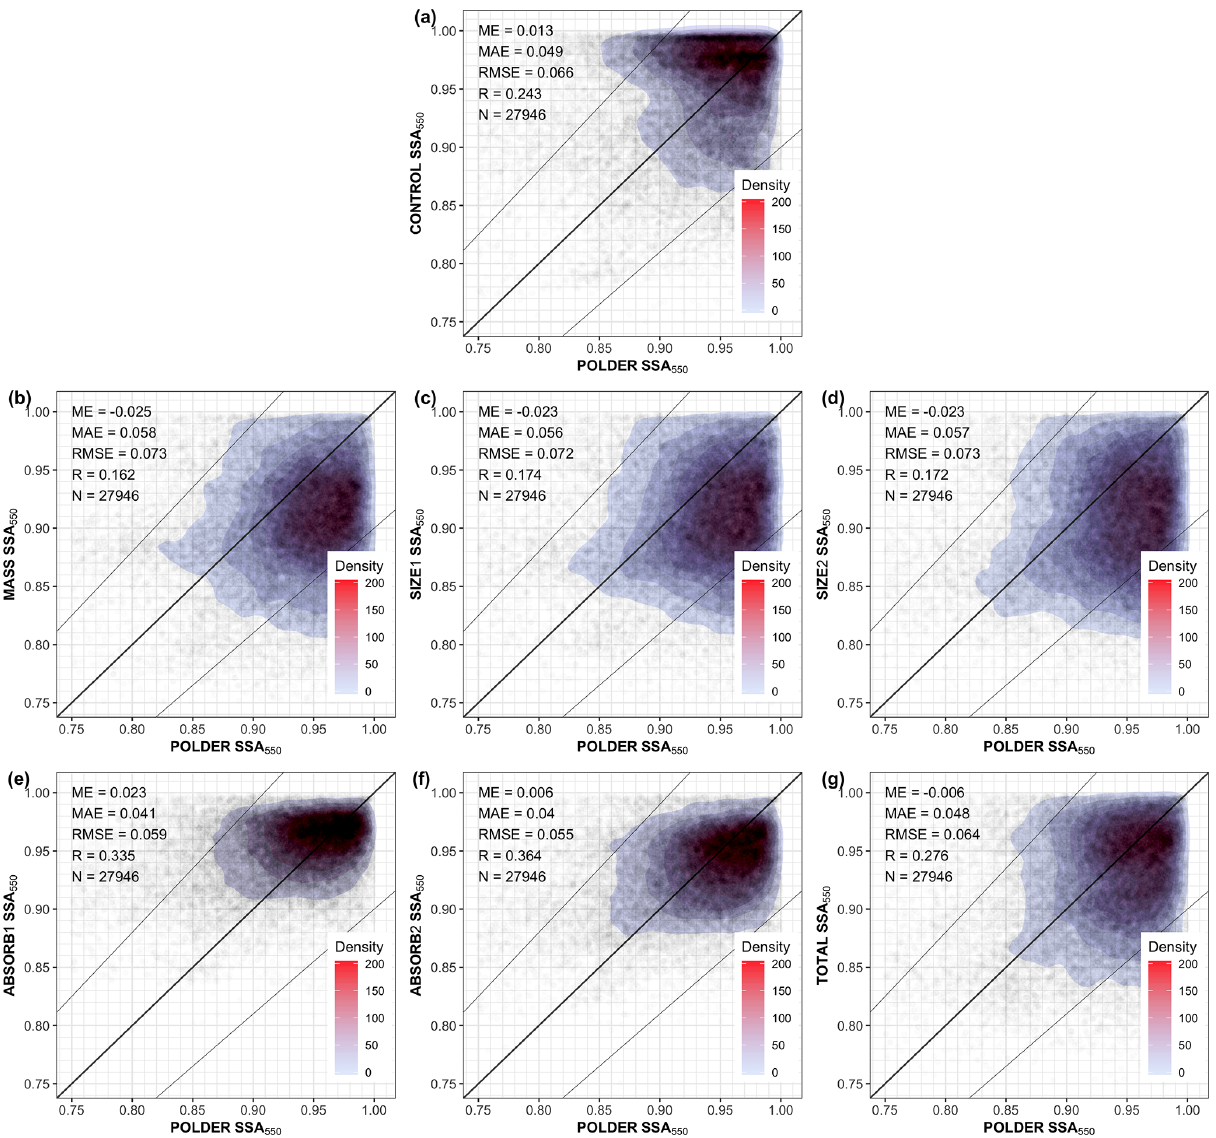
Figure 12. Similar to Fig. 6 but for single scattering albedo at 550nm. The two thinner lines show the − 10% and 10% bias boundaries,